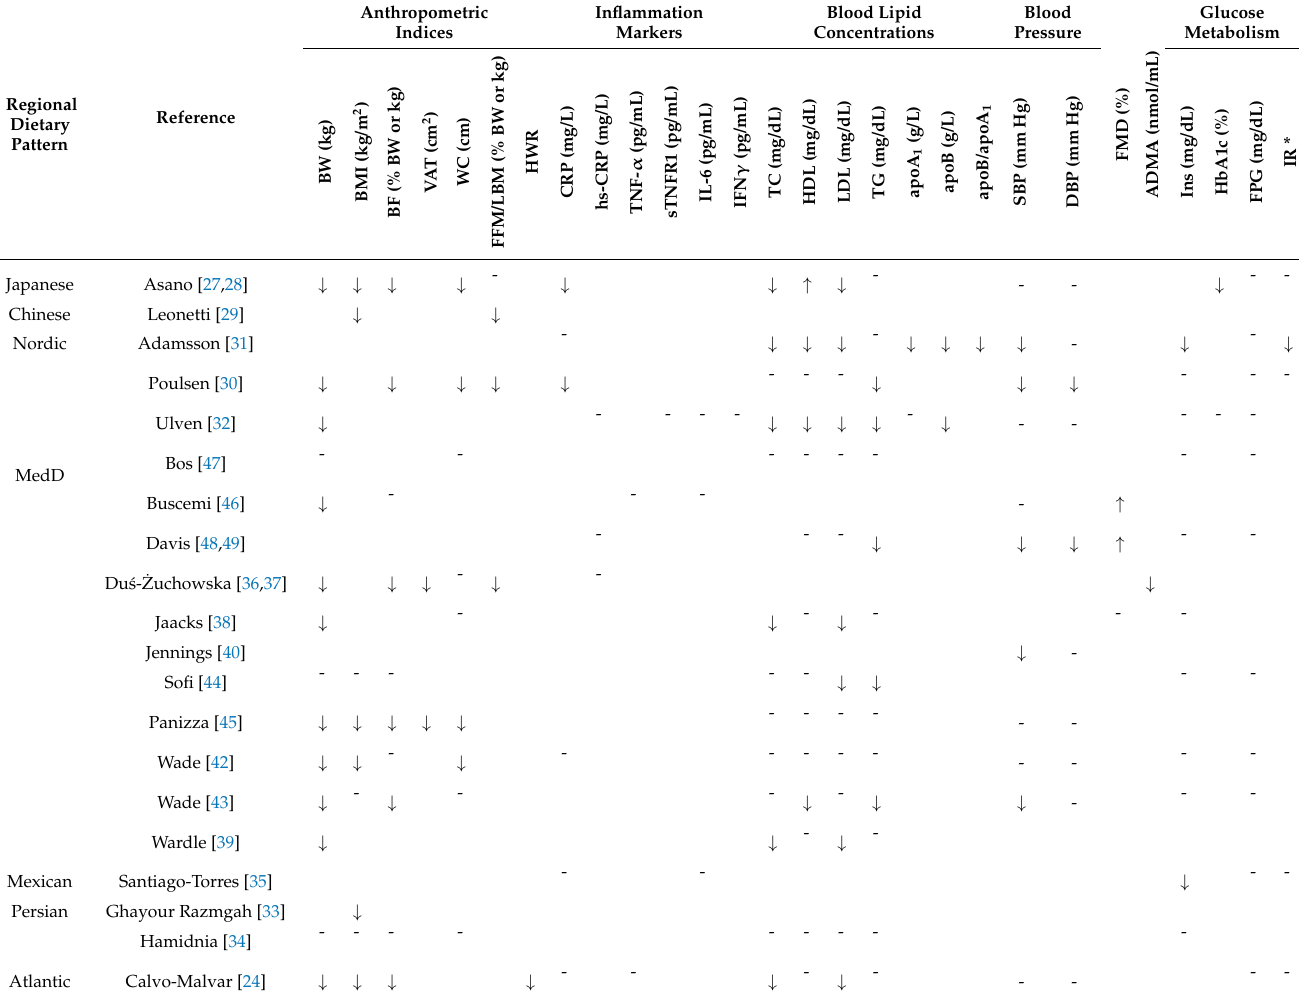
Table 4 details the CVD outcomes of the individual RCTs favoring the regional diet intervention arms. Table 4. Overview of CVD-specific outcomes (favoring the intervention arm) in RCTs implementing regional dietary patterns among participants with increased CVD